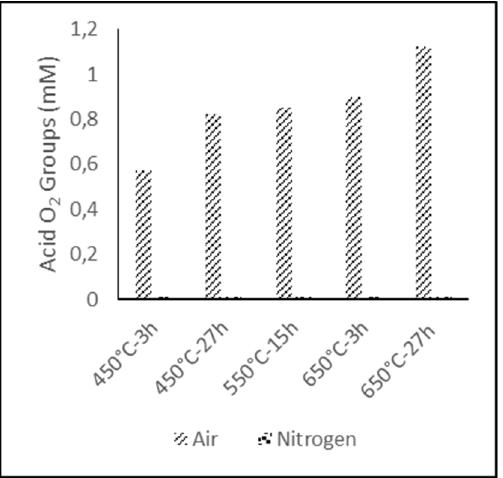
Figure 3. Oxygen acid groups concentration for thermally treated GF under air and nitrogen atmosphere.